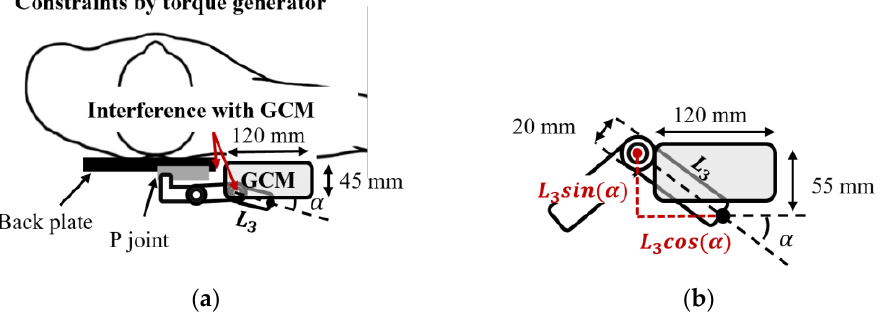
Figure 7. Constraints pertaining to interferences with the gravity compensation module (GCM): ( a ) Interferences with the back plate in medial trajectories, and those with the horizontal area of the GCM in the transverse plane. ( b ) Designable condition of 𝐿 3 and 𝛼 for avoiding interference with the horizontal area of GCM.